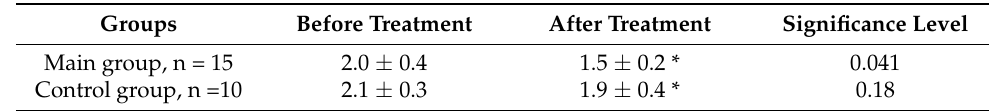
Table 7. Nail bed response to pressing in patients with CVI and peripheral atherosclerosis during treatment. Groups Before Treatment After